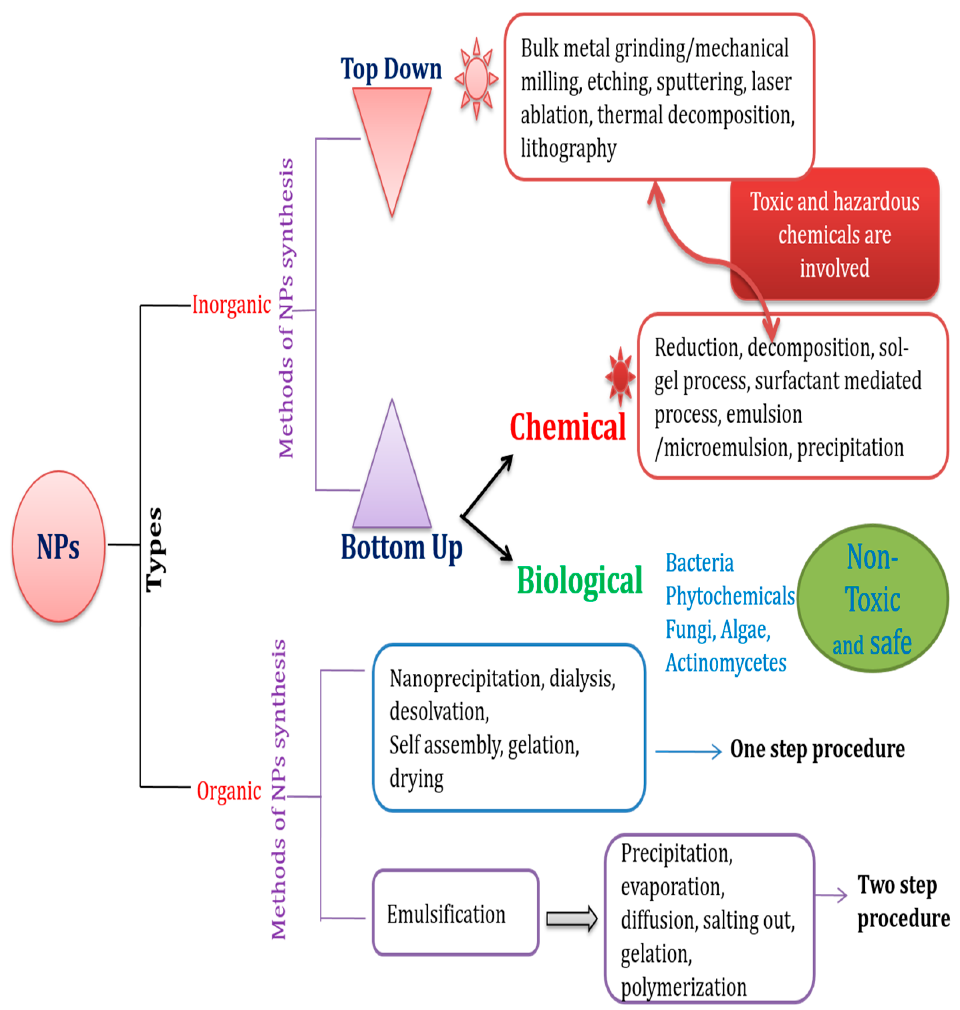
Figure 2. Schematic representation of the synthesis of nanoparticles (NPs) by various methods.